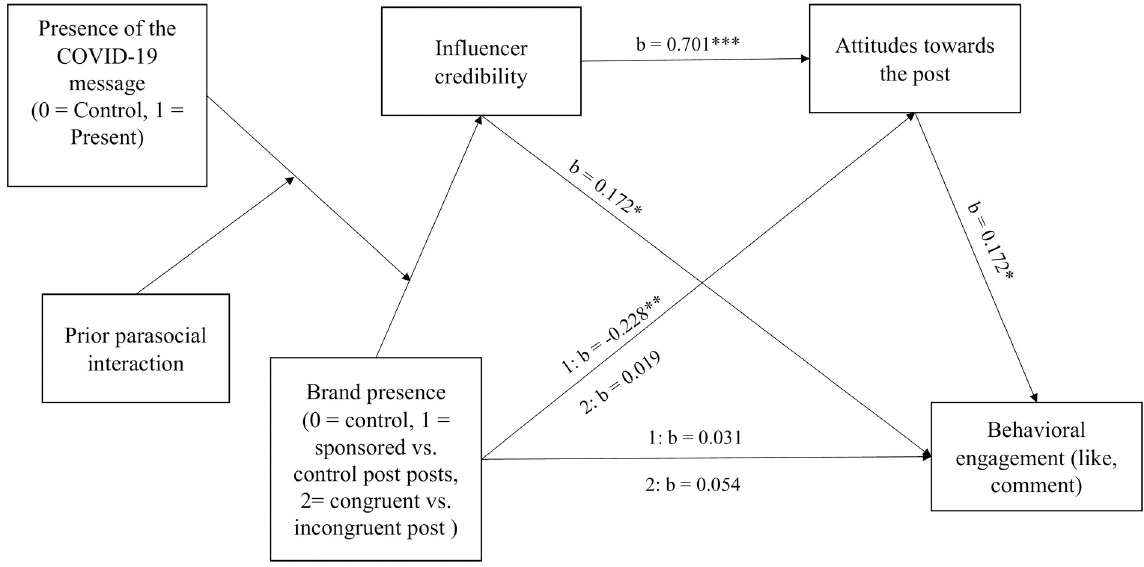
Fig 3. The mediation effects of the research model. � : p < .05, �� : p < .01, ��� p < .001.